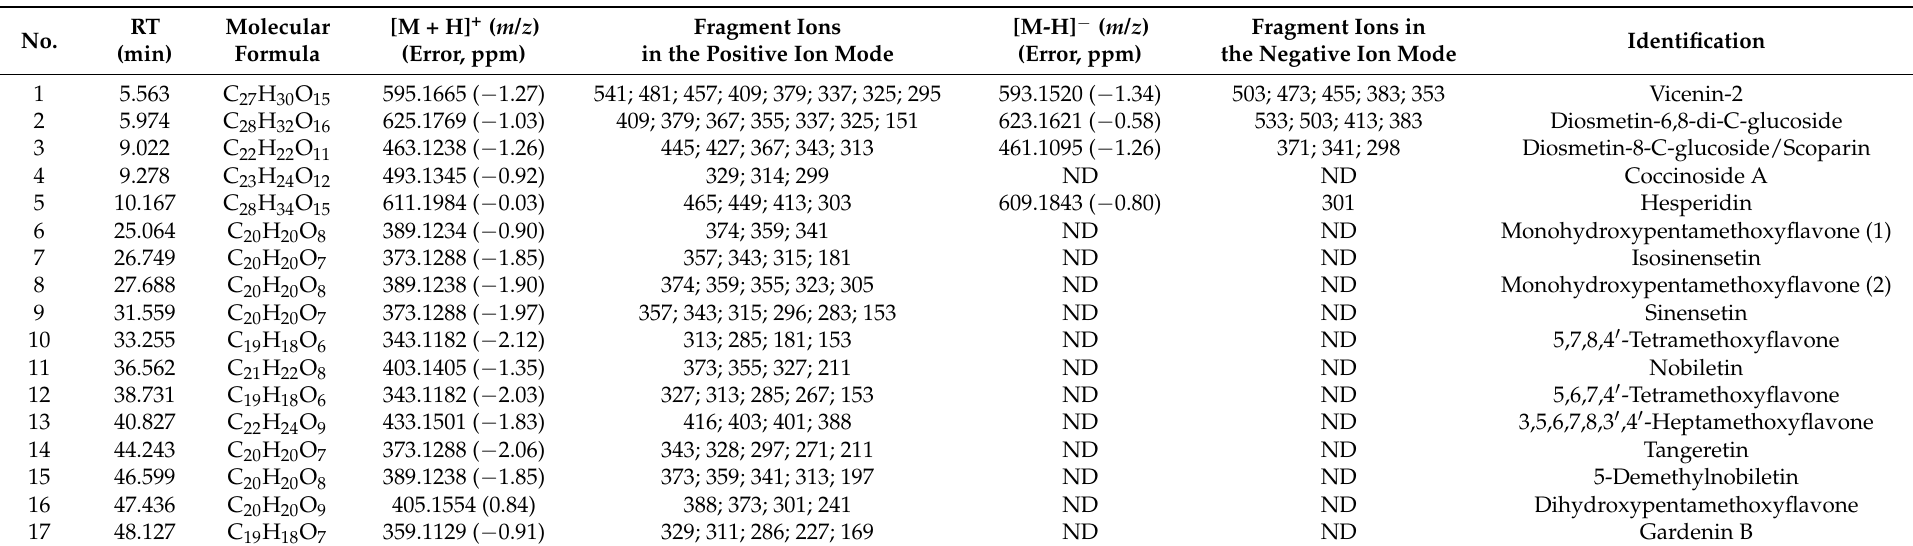
Table 1. Identification of the free flavonoids of PCR-C by